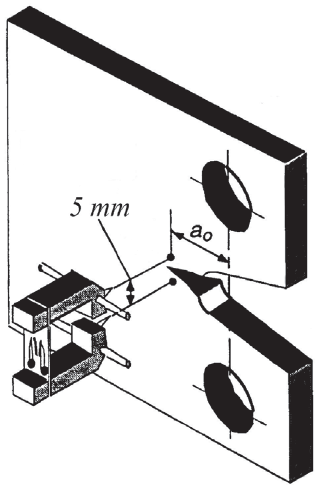
Figure 4. Experimental configuration for δ